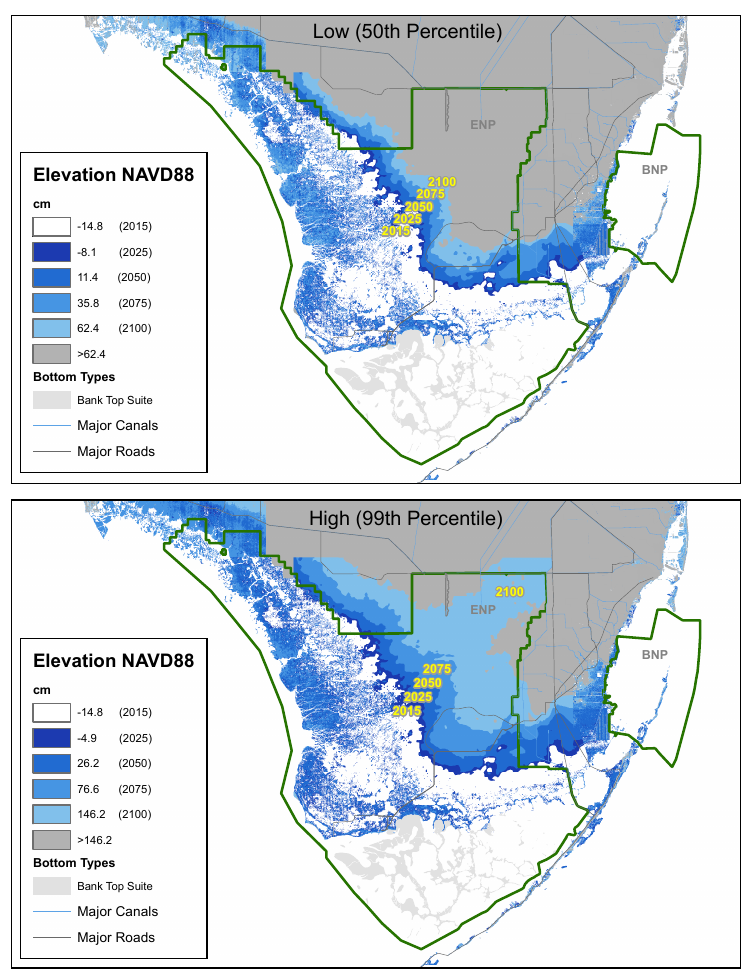
Figure 7. Mean sea level elevation maps for South Florida including Everglades and Biscayne National parks for the median (50th) and high (99th percentile) RCP 8.5 projections using current topography and the NAVD88 datum. Tides and storm surges are not included in this